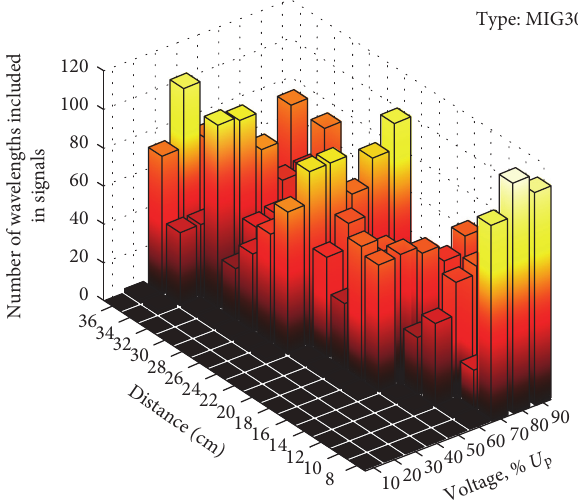
Figure 15: Dependency of voltage and distance on the highest intensity value for the AlMg5